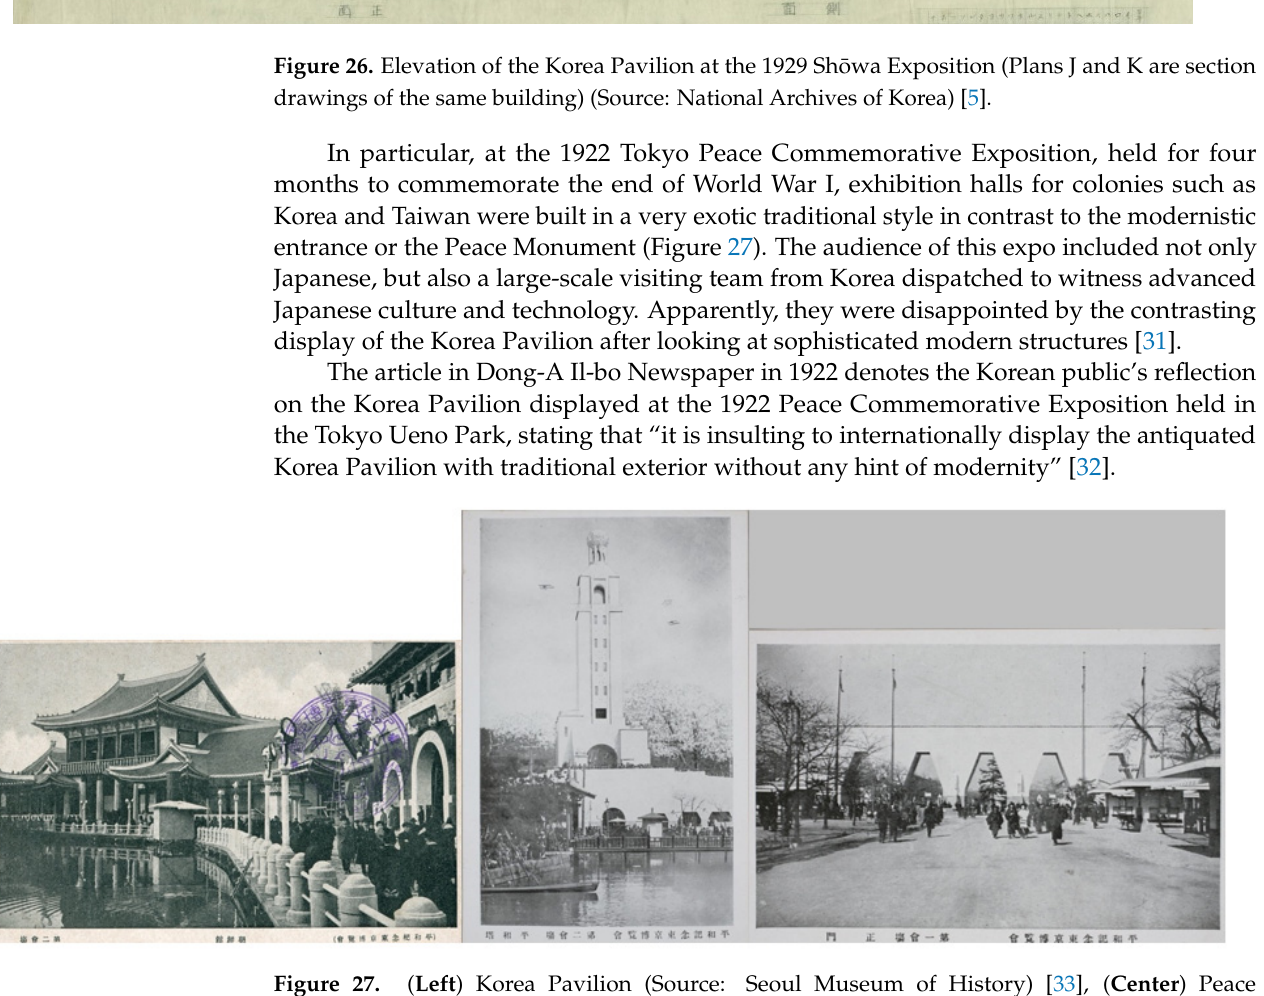
Figure 27. ( Left ) Korea Pavilion (Source: Seoul Museum of History) [33], ( Center ) Peace Tower. ( Right ) Main Gate at the 1922 Tokyo Peace Commemorative Exposition. Reprint with permission [34,35]; 2010, Tokyo Metropolitan Central Library.